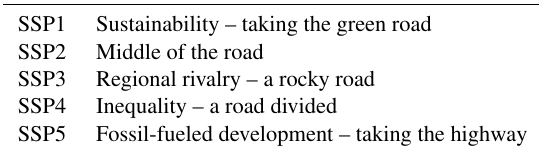
Table 3. Shared Socioeconomic Pathway (SSP) narratives.